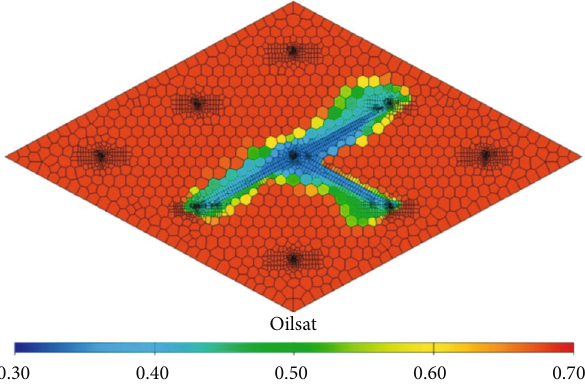
Figure 6: Distribution characteristics of seepage fi eld in the 10-year period of volumetric fracturing transformation of water injection